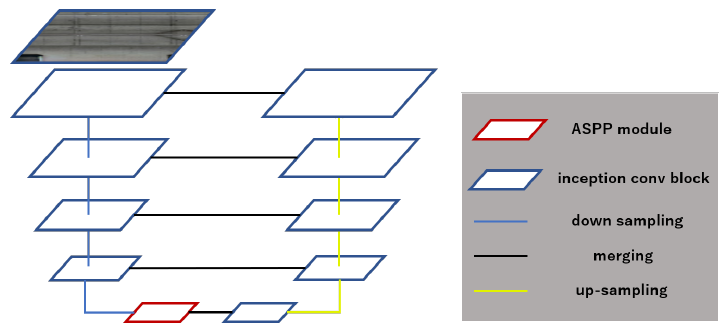
Figure 4. Overview of our defect detection network architecture.